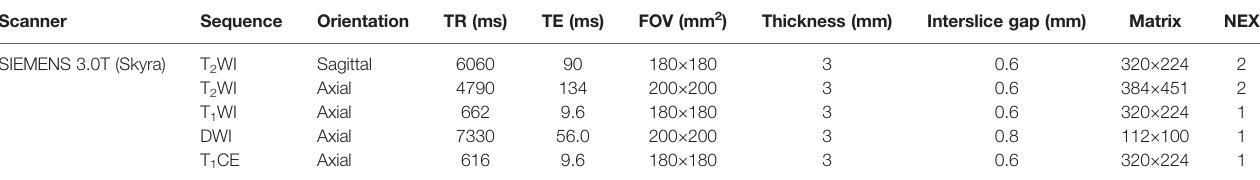
TABLE 1 | MRI parameters of each sequence.